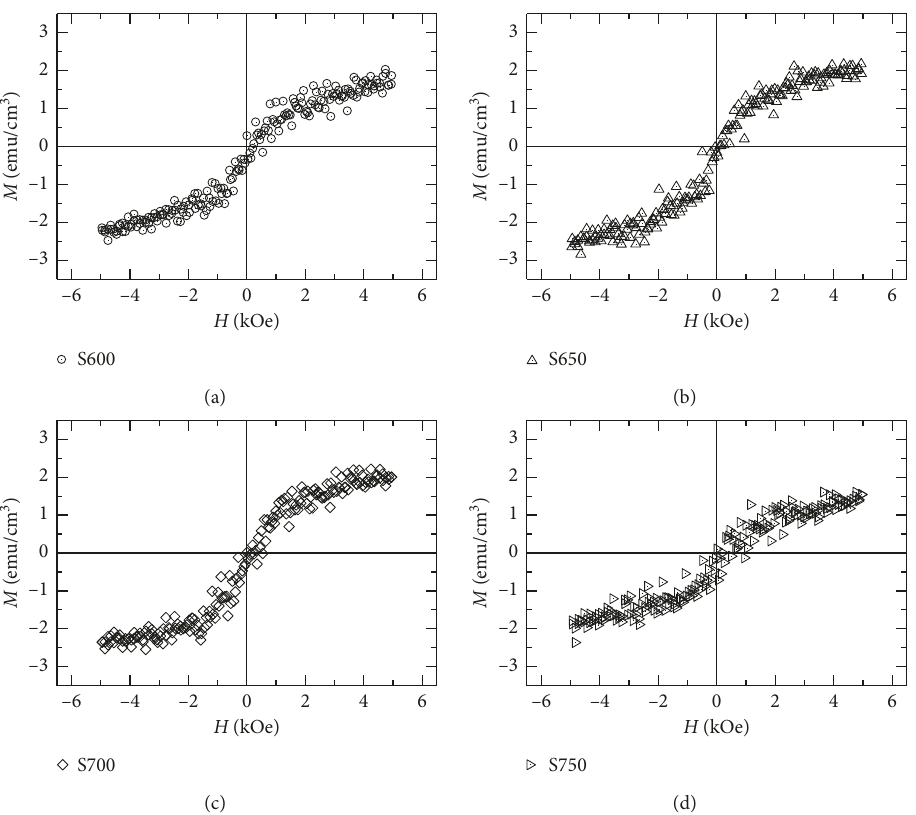
Figure 5: Room-temperature magnetic hysteresis (M-H) loops of BNKT films annealed at different temperatures with the applied magnetic field of 5